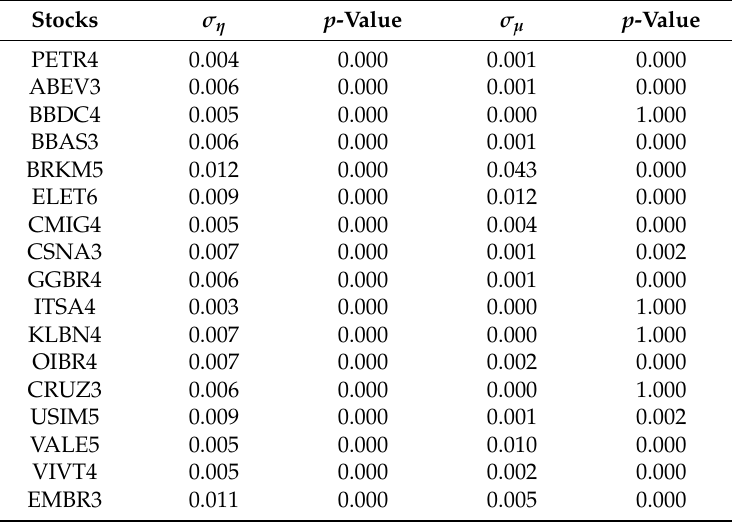
Table A8. Coefficients of the model with random